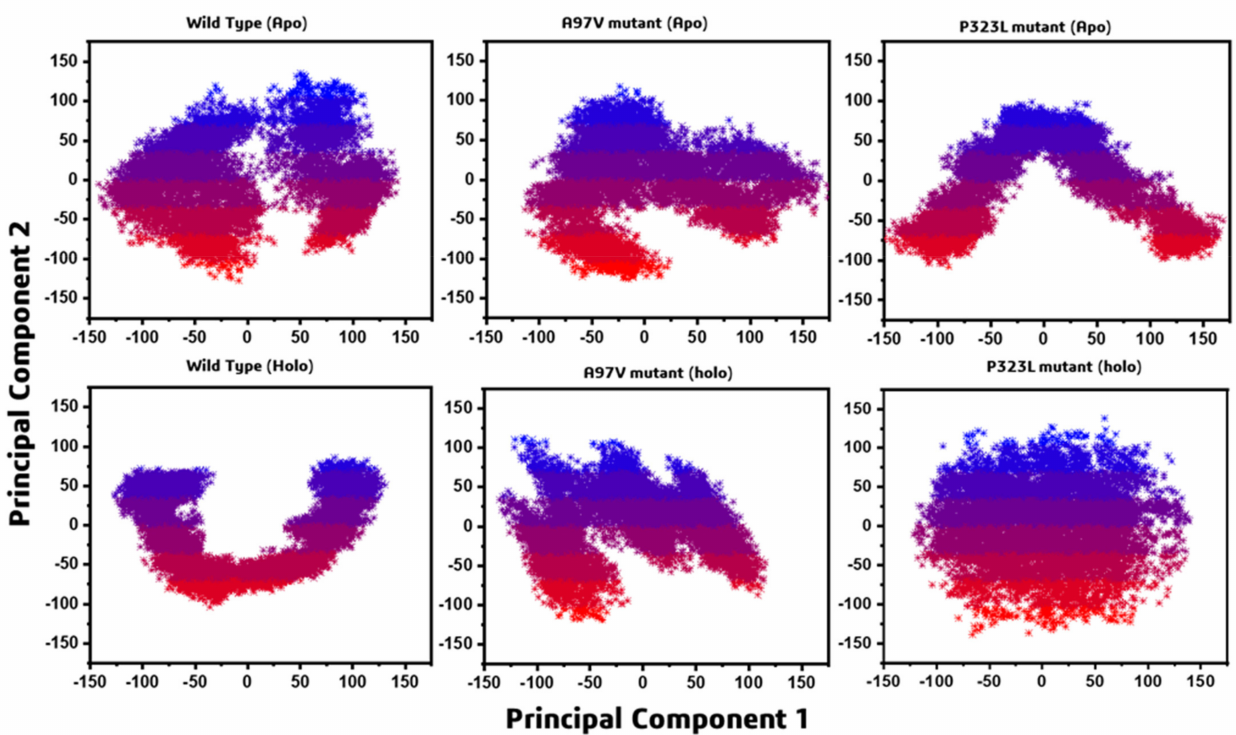
Figure 5. Principal component analyses (PCA) were plotted against each other; Apo WT, A97V and P323L RdRp and WT-RD, A97V-RDV and P33L-RDV RdRp